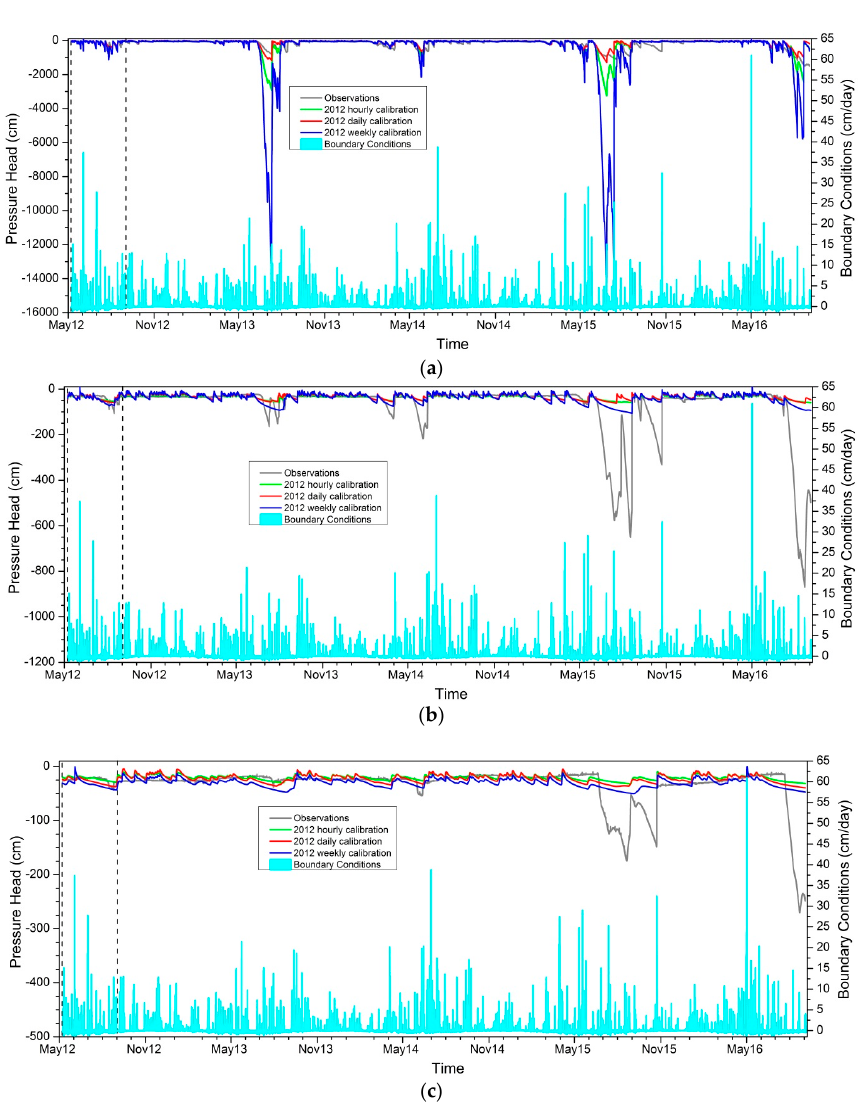
Figure 4. Pressure head values modeled for the period from May 2012 to September 2016. The model is calibrated using hourly, daily, and weekly data for the period from June to September 2012 (limited by vertical straight lines): pressure head values at depths of 42 cm ( a ), 71 cm ( b ) and 116 cm ( c ).